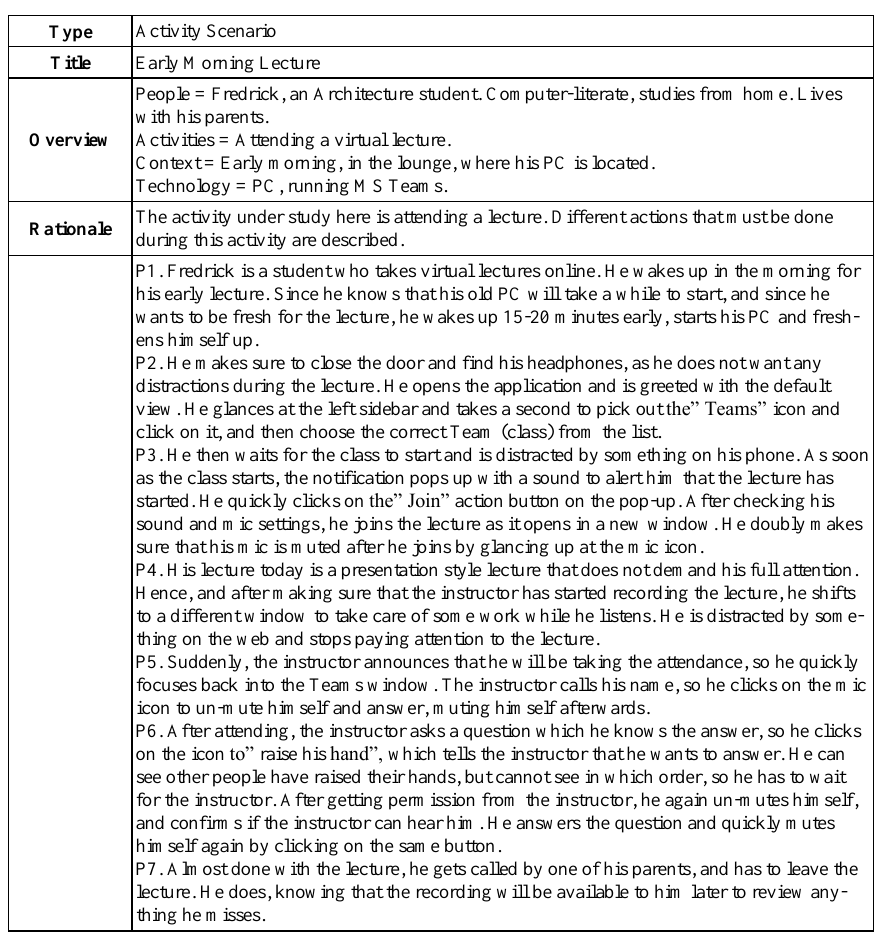
Table 4. Early learning lecture activity - test